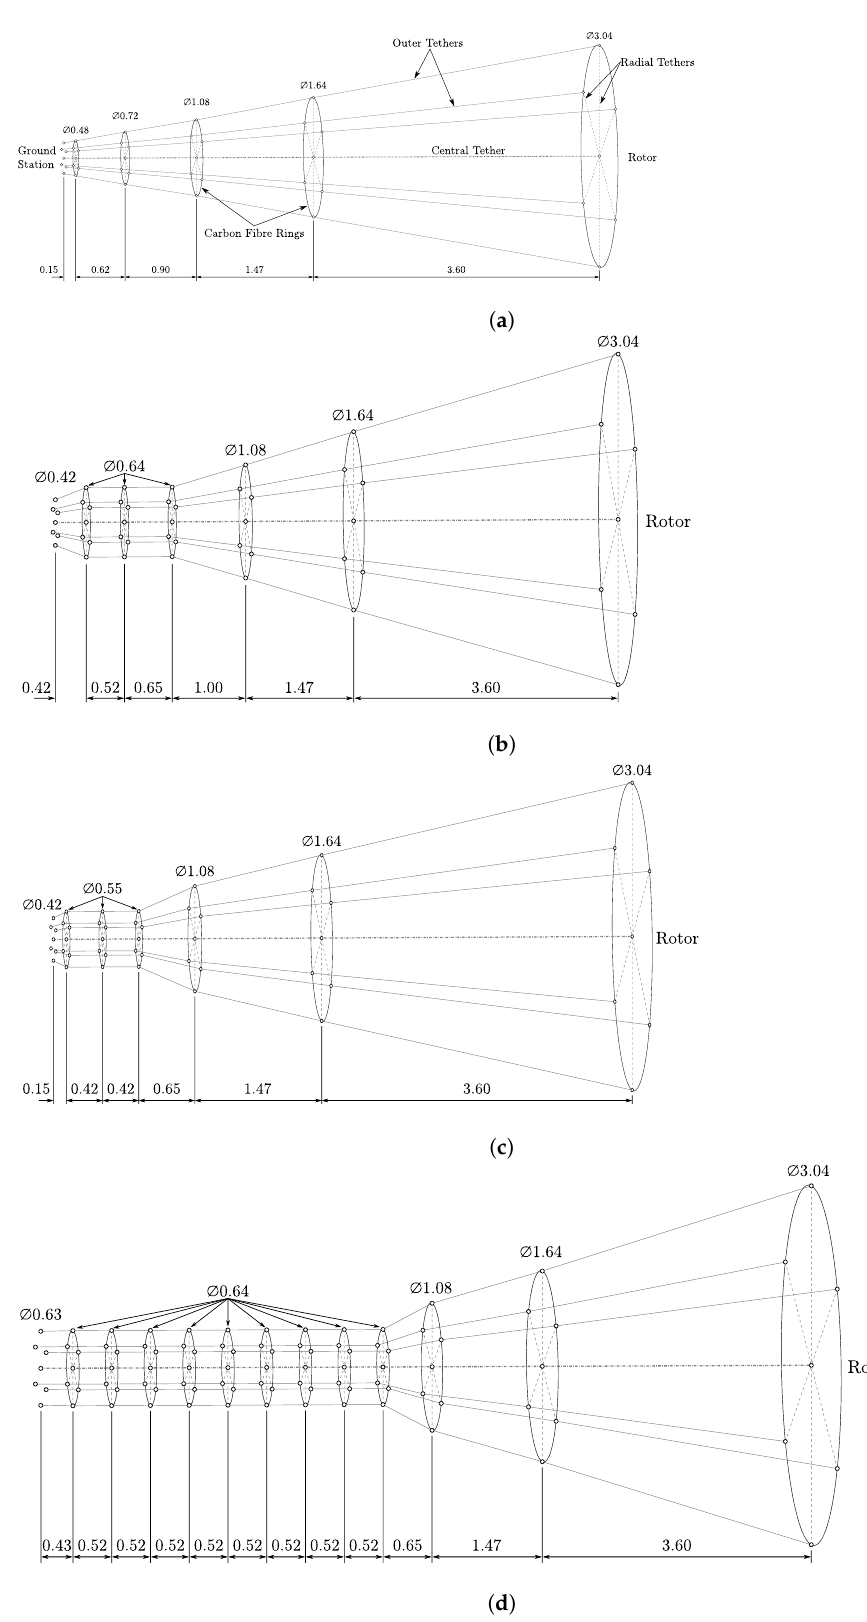
Figure A1. Diagrams of TRPT iterations 1, 2, 3, and 4 used throughout this work. ( a ) TRPT −